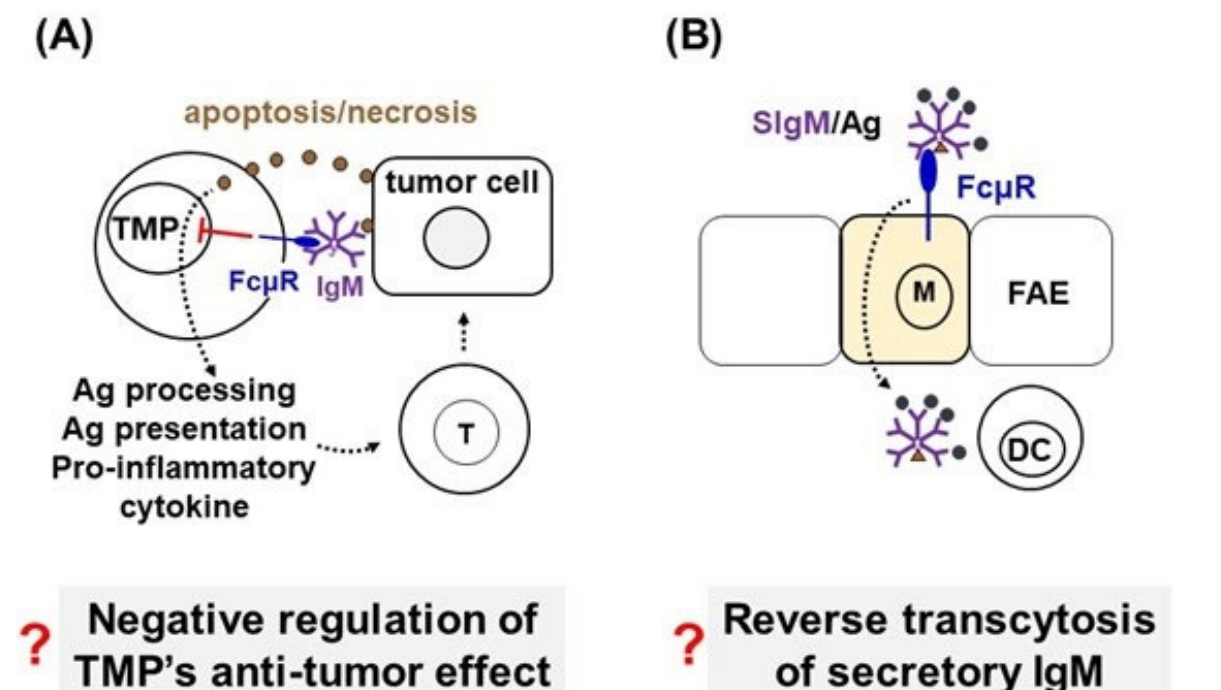
Figure 1. Disputes on the cellular distribution of Fc µ R in mice. ( A ) Questioning the negative regulation of tumor growth by Fc µ R expressed on tumor-associated mononuclear phagocytes (TMPs). TMPs engulf cell debris from apoptosis or necrosis of tumor cells and process and present antigens to T cells and produce proinflammatory cytokines. Fc µ R (blue tennis racket) expressed by TMPs inhibits this process by interacting with IgM anti-tumor antibody (purple pentamer). ( B ) Questioning the reverse transcytosis of secretory IgM (SIgM)/antigen complexes via Fc µ R expressed by the apical portion of microfold (M) cells in the follicle-associated epithelium (FAE) from the intestinal lumen to dendritic cells (DC). SIgM is shown as a purple pentamer plus a triangle secretory component and antigens as black circles.